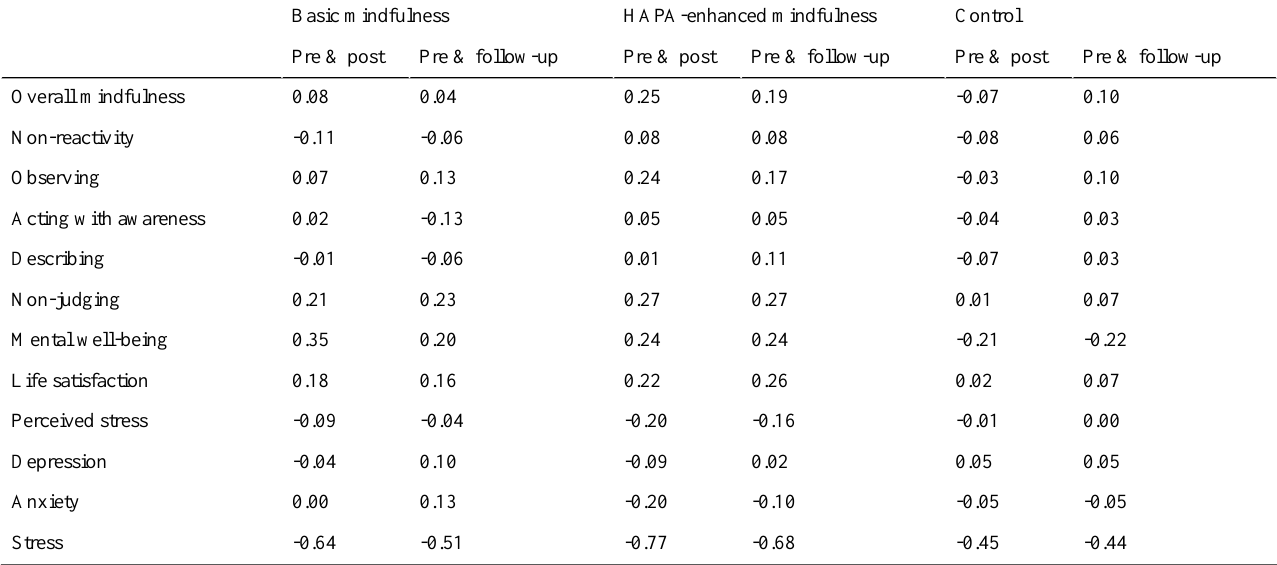
Table 2. Effect size (Cohen’s d ) among basic mindfulness, HAPA-enhanced mindfulness, and waitlist control groups on